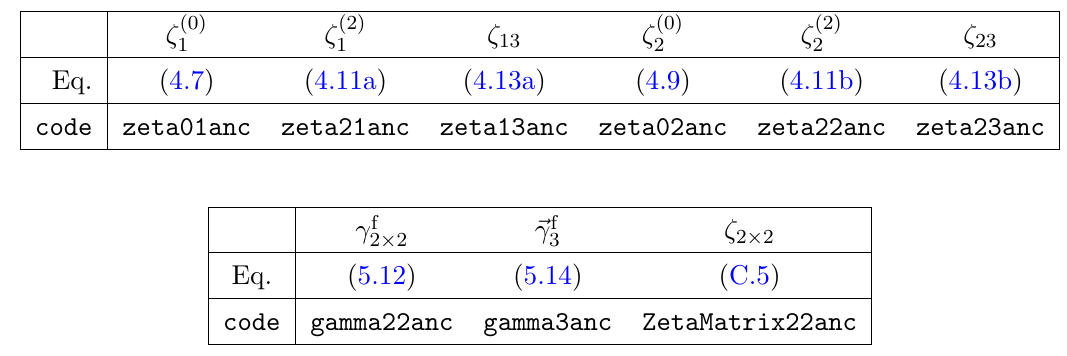
Table 1 . Notation in the supplementary